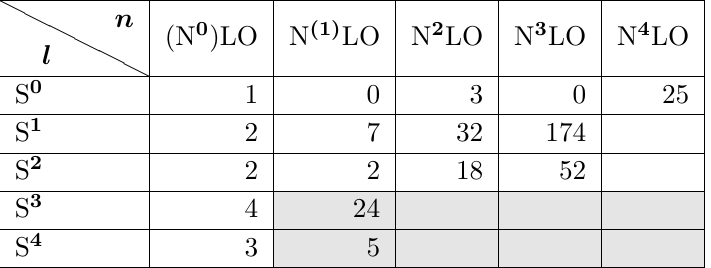
Table 1 . The complete state of the art of PN gravity theory for the orbital dynamics of generic compact binaries. Each PN correction enters at the order n + l + Parity ( l ) / 2 , where the parity is 0 or 1 for even or odd l , respectively. We elaborate on the meaning of the numerical entries and the gray area in the